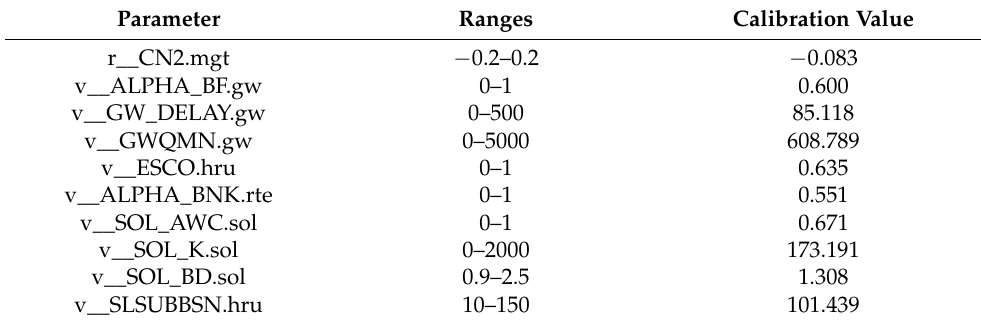
Table 2. The parameter calibration results of